Question: What style of plot is this figure drawn as?
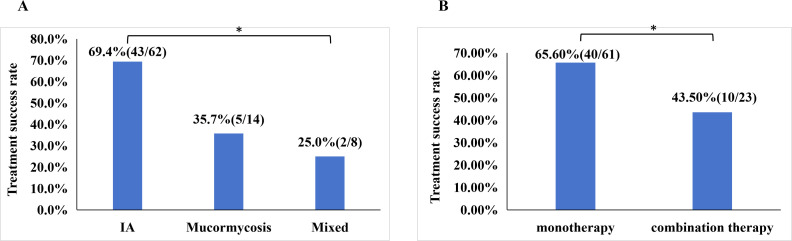
Answer: bar